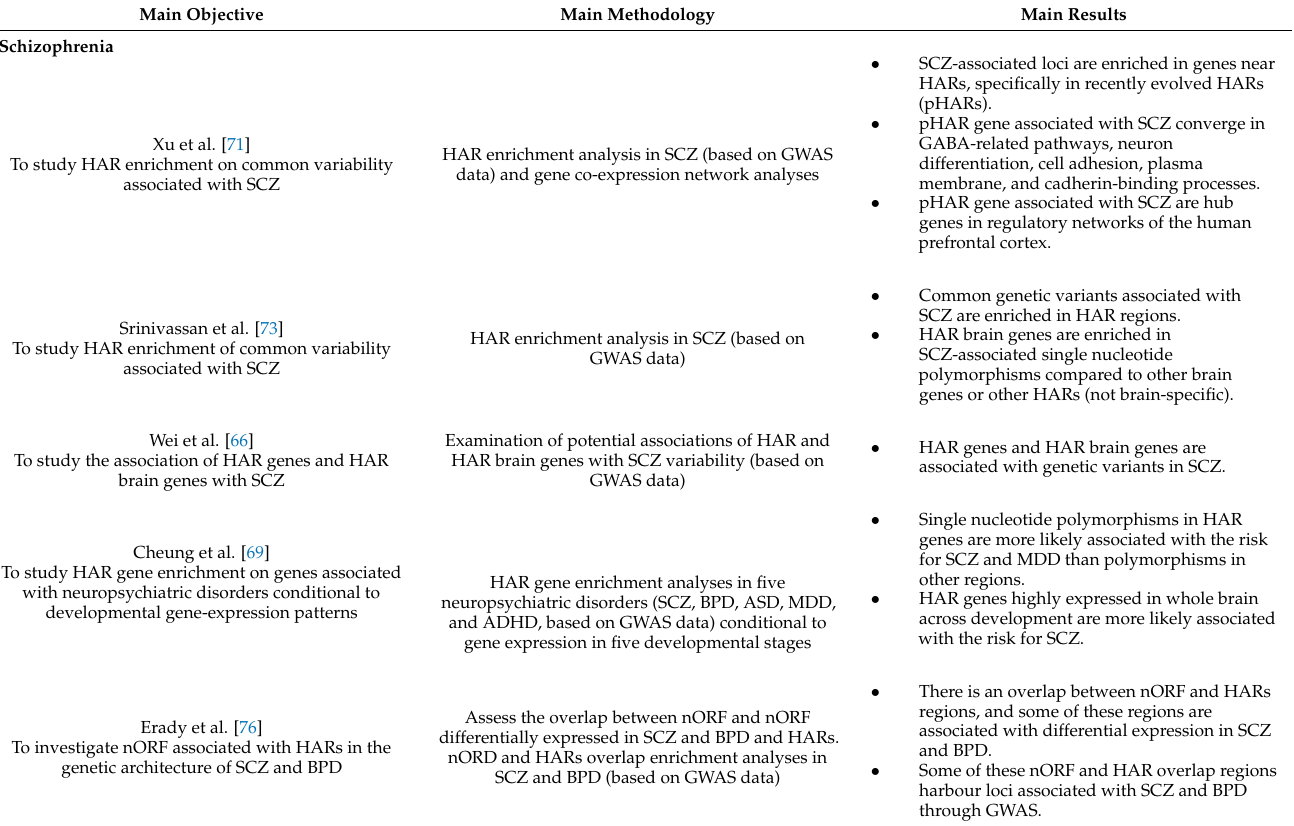
Table 4. Summarised findings of the studies assessing the role of HARs in psychiatric